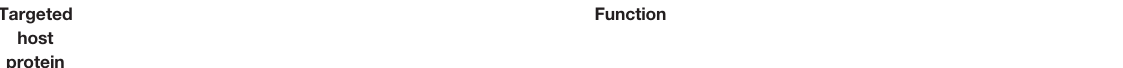
TABLE 2 | Host factors that facilitate ZIKV entry into different host cells.